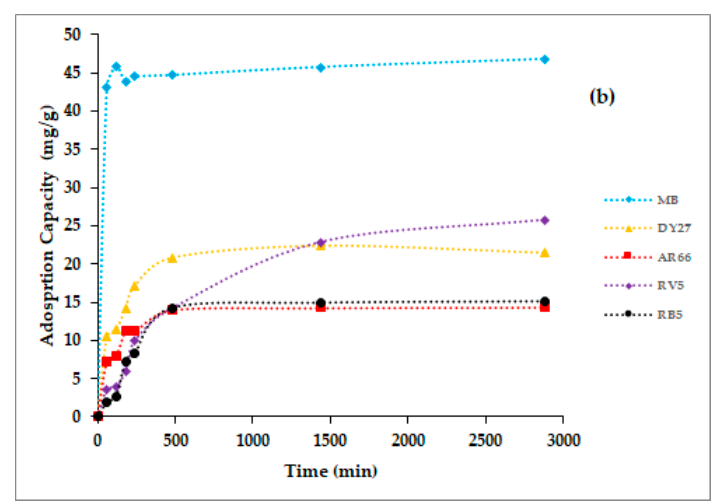
Figure 3. Adsorption capacity of various dyes onto digestate adsorbents. Ratio 1:50 (W adsorbents = 0.05 g: Cdyes = 50 mg/L). ( a ) Not washed digestate adsorbent, ( b ) washed digestate adsorbent.